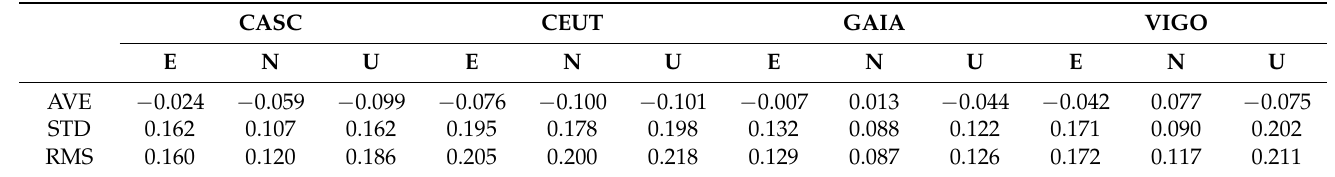
Table 7. Statistic of the errors for all Galileo + GPS solutions in Test 1.